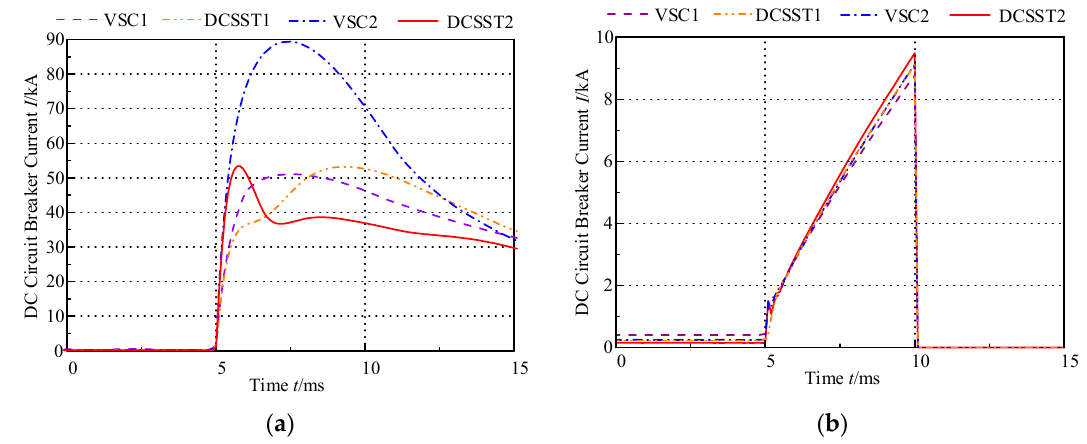
Figure 15. The current of the DC circuit breakers in each device under F2 fault: ( a ) without current limiting reactors and ( b ) with current limiting reactors.